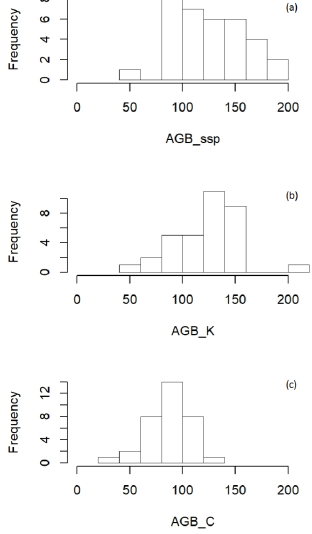
Figure 2. Histogram of aboveground biomass (ABG, t·ha −1 ) for: ( a ) species-specific equations (AGB_ssp) and the pantropical equation of Komiyama et al. [44]; ( b ) (AGB_K) and Chave et al. [56]; ( c ) (AGB_C) of 34 field plots scattered across the mangrove area inside the APA Guapimirim and ESEC Guanabara. The AGB estimates obtained with pantropical allometries (Chave et al. [56] and Komiyama et al. [44]) essentially differ from one another by a scaling factor (Table 1). However, the plot AGB predictions of both models differ markedly from the predictions obtained using species-specific allometries (see Figure 3). Figure 4 shows the correlation between structural parameters, AGB species-specific metrics, and lidar metrics for 34 plots. Figure 5 shows the lidar point cloud for three mangrove field plots with contrasting AGB values: plot 25 that presents the lower AGB_ssp value with 45.65 t·ha −1 , plot 09 with AGB_ssp value of 126.37 t·ha −1 , and plot 20 the highest AGB_ssp with 186.10 t·ha −1 .